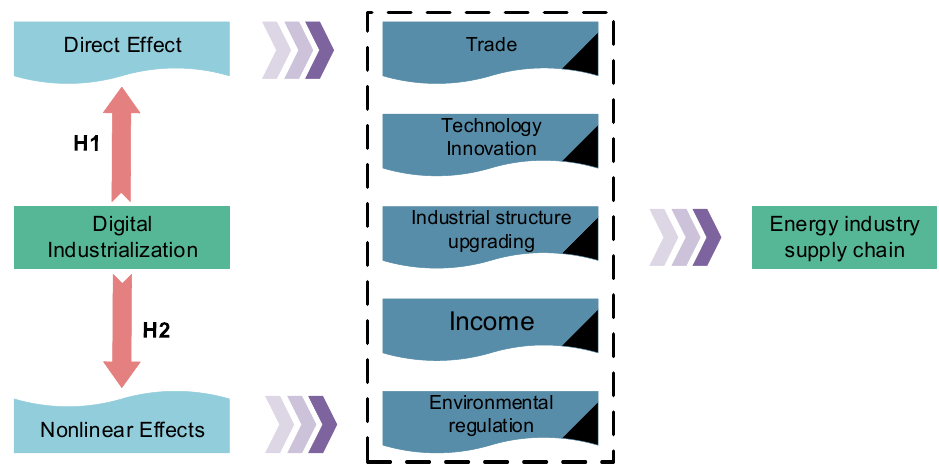
Figure 1. Research hypothesis framework diagram. Note: The diagram was created by the author using VISIO 2019.